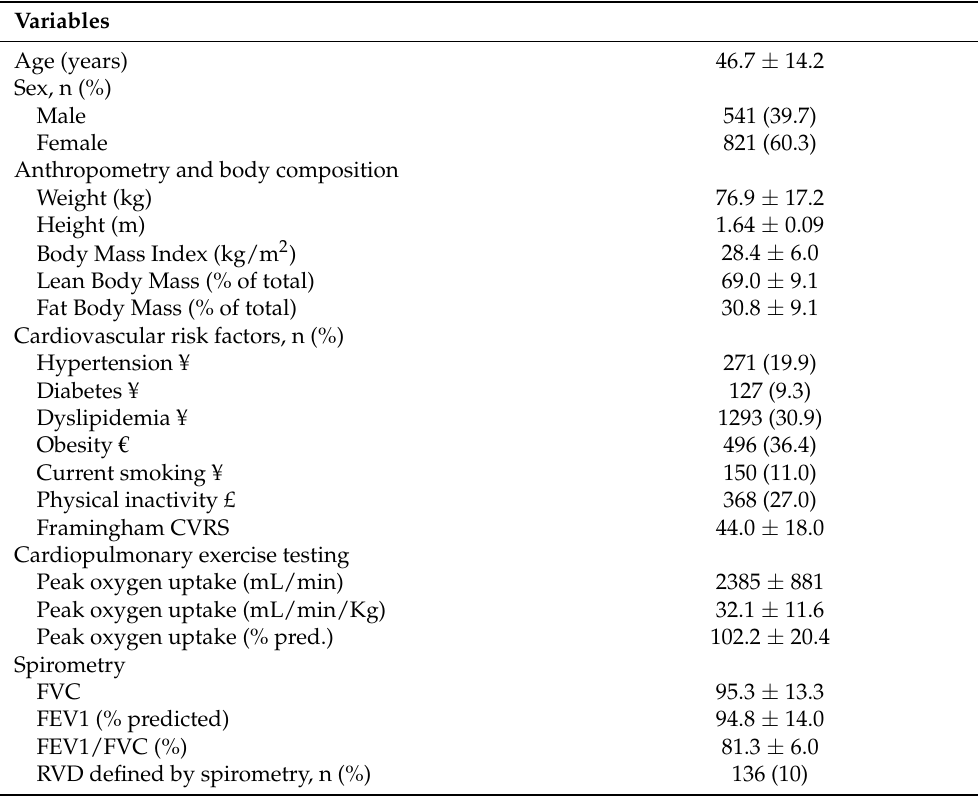
Table 1. General characteristics of the studied sample ( n = 1362).